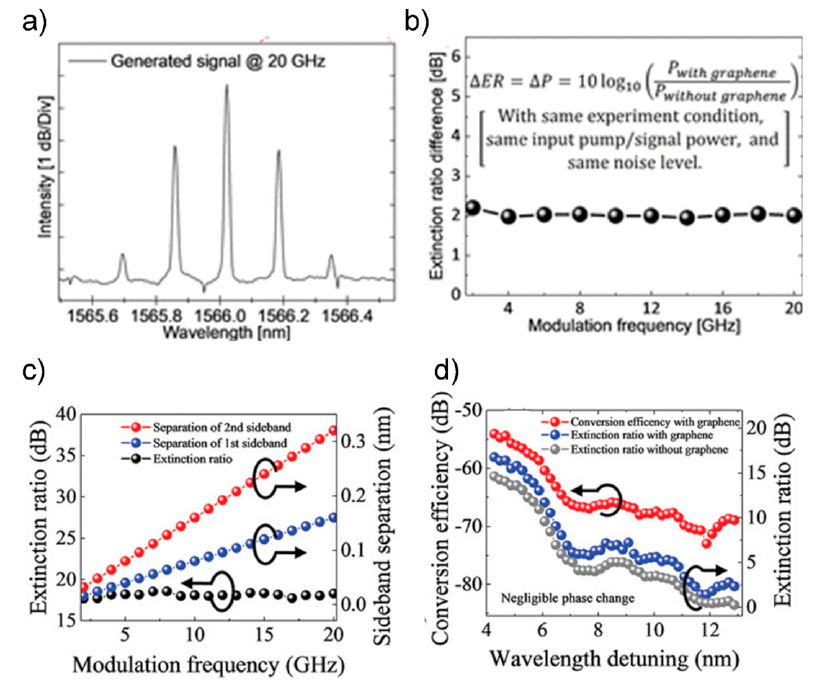
Figure 8. ( a ) Generated signal corresponding to original signal; ( b ) Extinction ratio (ER) comparison for without and with in-situ graphene cases; ( c ) Modulation frequency dependent sideband separa- tion in FWM demonstration with ACS graphene; ( d ) Wavelength detuning dependent conversion efficiency (red curve) and ER (blue curve) for confirming negligible phase-mismatch during FWM experiment. ( a , b ) Reproduced with permission from [83]. Copyright American Chemical